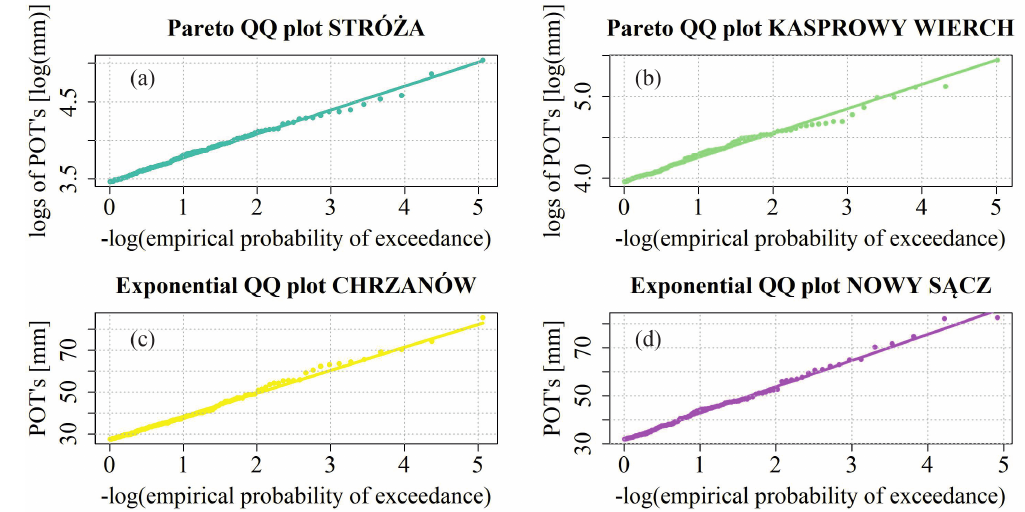
Figure 4. QQ plots for four exemplary stations. ( a , b ) Pareto QQ plot. ( c , d ) exponential QQ